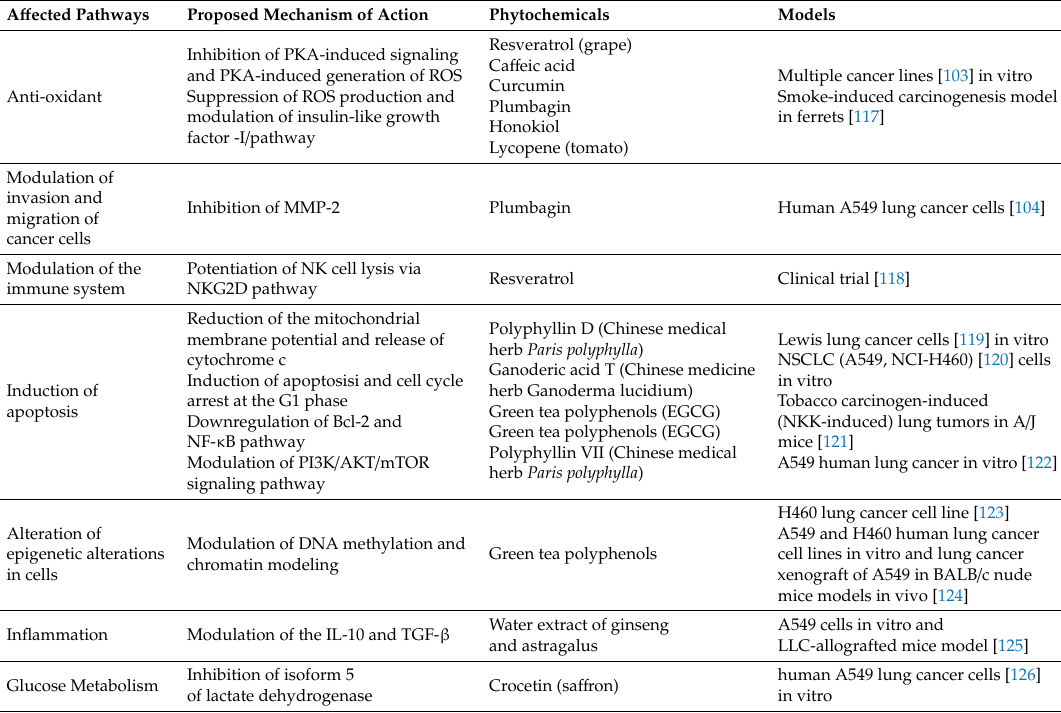
Table 1. Role of selected phytochemicals in